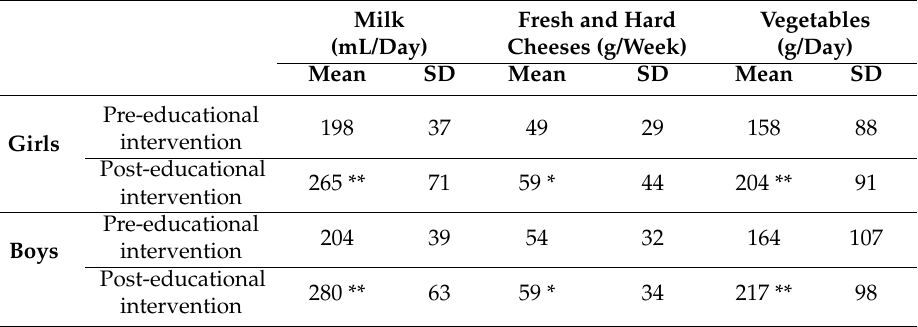
Table 3. Intake of milk, fresh and hard cheese, and vegetables before and after the educational